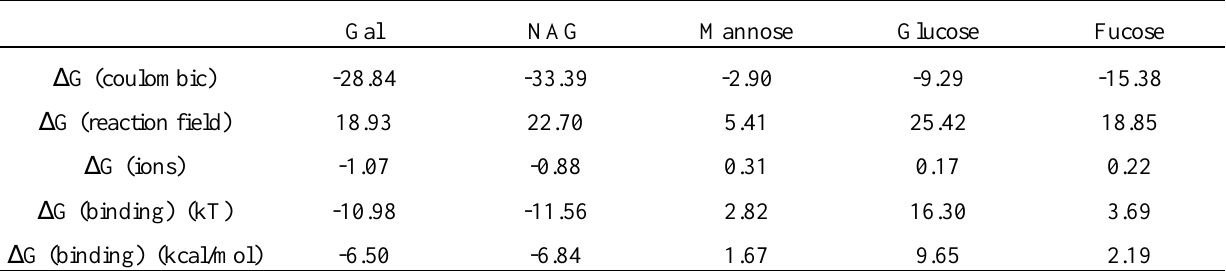
Table 3. Energetic contributions computed by DelPhi and involved in the D G